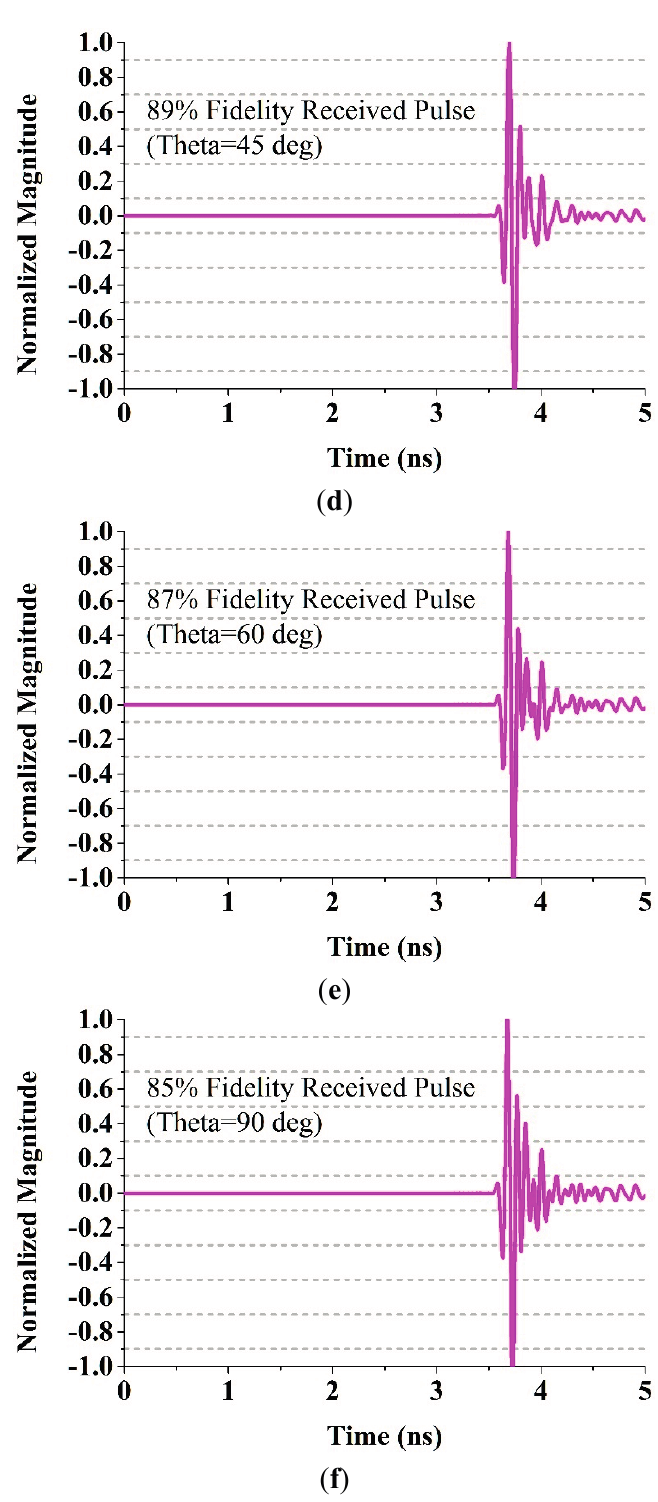
Figure 22. Normalized received signals by virtual probe for Phi = 90° and varying Theta in the E-plane, ( a ) Antenna with probe; ( b ) Theta=0°; ( c ) Theta = 30°; ( d ) Theta = 45°; ( e ) Theta = 60°; ( f ) Theta =